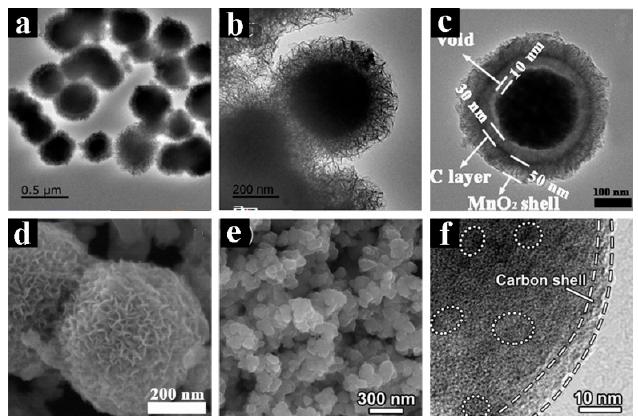
Figure 3. Graphical illustration of core-shelled spheres: ( a , b ) transmission electron microscopy (TEM) images of the core-shelled Fe 3 O 4 / PANI / MnO 2 hybrids. ( c ) TEM and ( d ) scanning electron microscopy (SEM) images of the core-shelled Fe 3 O 4 @C@MnO 2 microspheres [95]. ( e ) field-emission scanning electron microscopy (FESEM) image and ( f ) TEM image of the core-shelled SiO x -TiO 2 @C nanospheres [96]. Pictures ( a ) and ( b ) were reprinted with permission from Reference [94]. Copyright Royal Society Chemistry, 2017. Pictures ( c ) and ( d ) were reprinted with permission from Reference